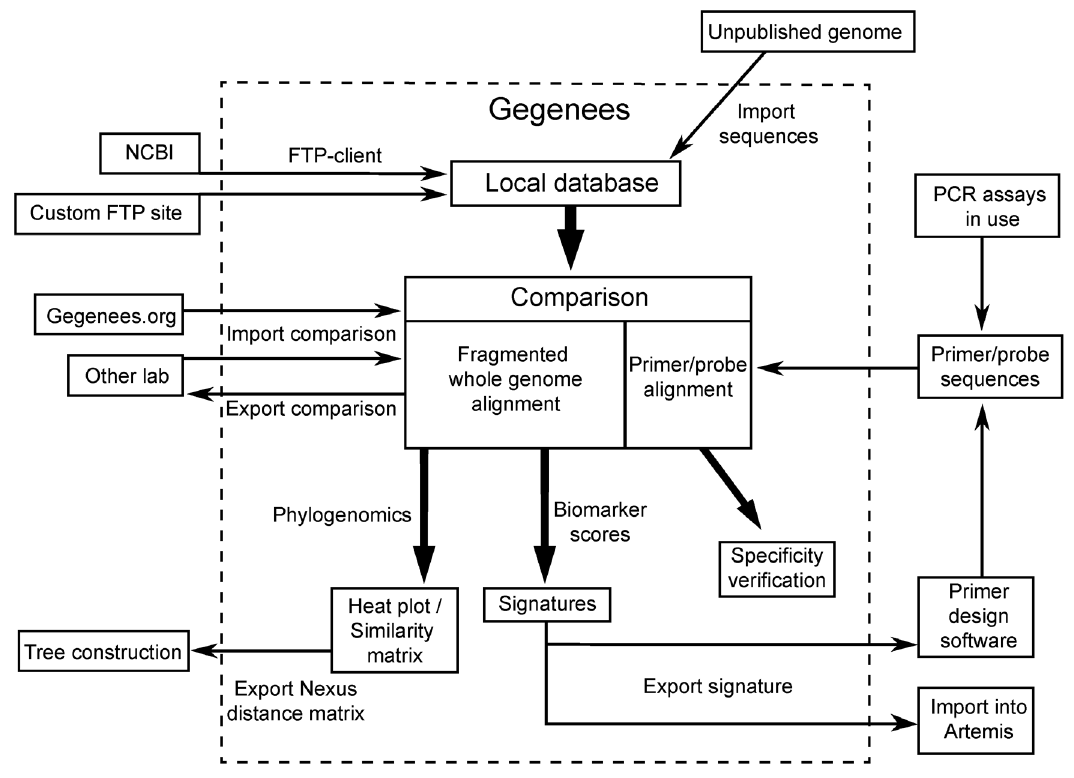
Figure 1. Overview of Gegenees. The Gegenees workspace contains one or several local databases. Genomes can be downloaded from the NCBI ftp site or from custom ftp sites through a built-in ftp client. This client compares the content of the local database with the remote one and highlights genomes already present locally. Unpublished genomes or genomes downloaded from other sources can be imported. The Gegenees workspace can also contain comparison projects. Genomes are added to the comparison from the local database. Genomes already in the active comparison are highlighted in the local database to facilitate the update process. Comparisons can also be downloaded from www.gegenees.org or shared between labs and imported into the workspace. One or several fragmented alignments can be made in the comparison with custom-specified resolution. Large alignments are associated with lengthy calculations and can therefore be paused and later resumed. Genomes can also later be added to a completed alignment that is then updated with the missing data points. When an alignment has been completed, the phylogenomic context can be analyzed in heat-plots. Nexus files can be exported for dendrogram construction and heat plots can be exported for high-resolution printouts. The alignment can then be analyzed in terms of Biomarker scores and uniqueness signatures. A target and a background group are defined on the basis of strain phenotypes and phylogenomic overview. The resulting conservation pattern signature can then be viewed and explored graphically or in tables. The signatures can also be exported to Artemis. Primers and/or probes can be designed from the signatures and candidate primers can be added back to Gegenees in form of a primer/probe alignment. Primer specificity can then be analyzed in terms of mismatches in the target and background